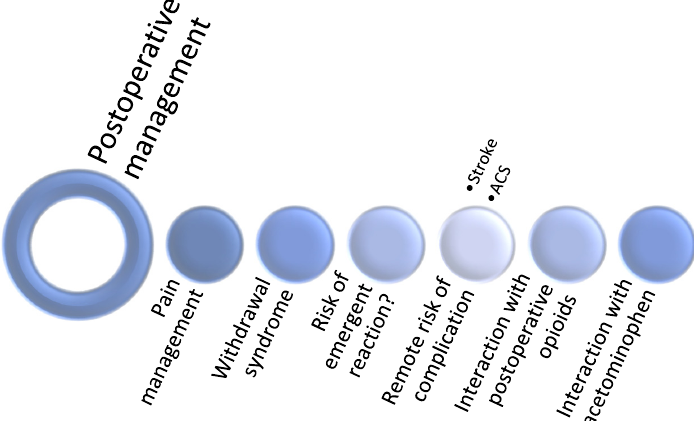
Figure 4. Postoperative consideration for cannabinoid users .